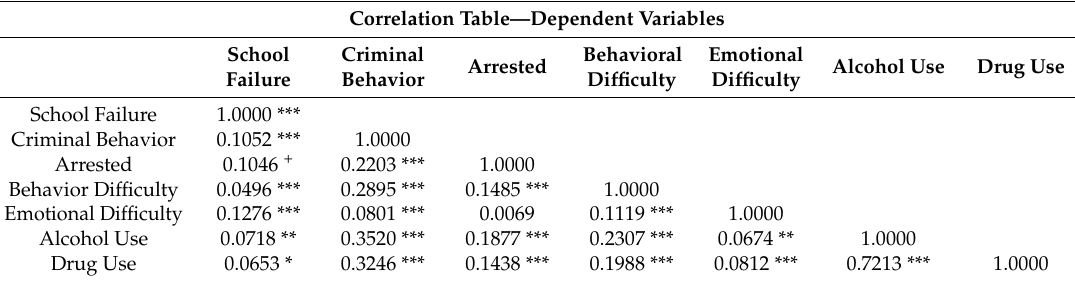
Table 1. Correlations among Dependent Variables (Outcomes). Correlation Table—Dependent